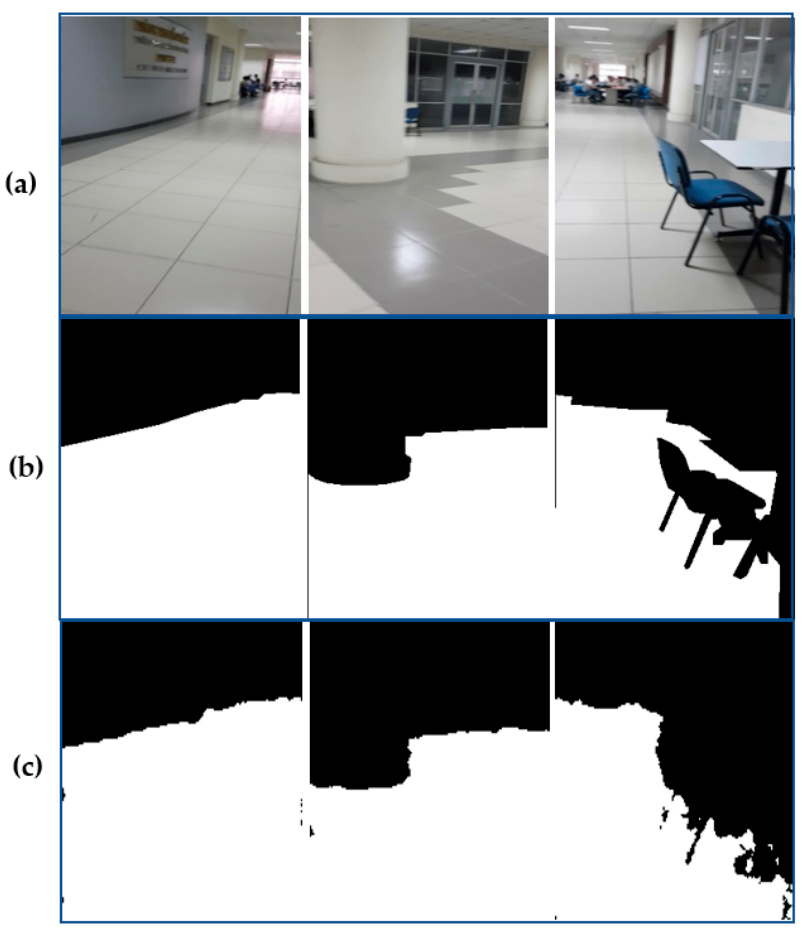
Figure 4. Segmentation results of the Ta Quang Buu library’s environment: ( a ) raw images; ( b ) ground truths; and ( c ) predictions.